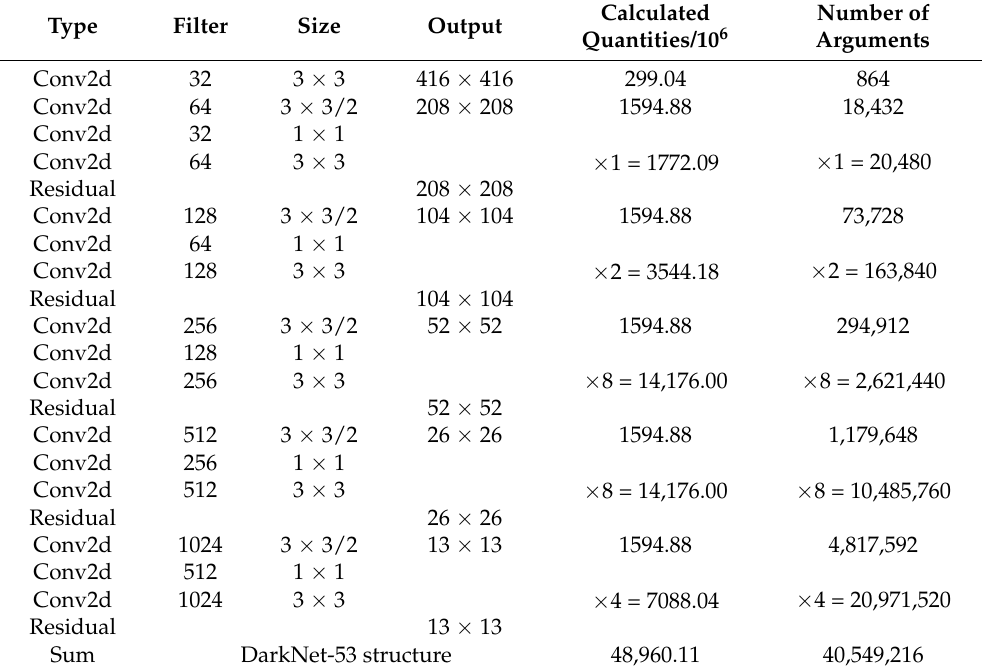
Table 1. Number and computations of DarkNet-53